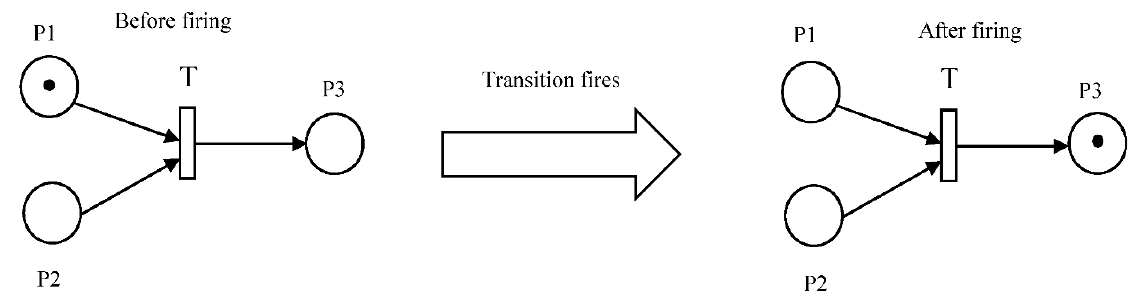
Figure 3. Representation of a Petri network model.